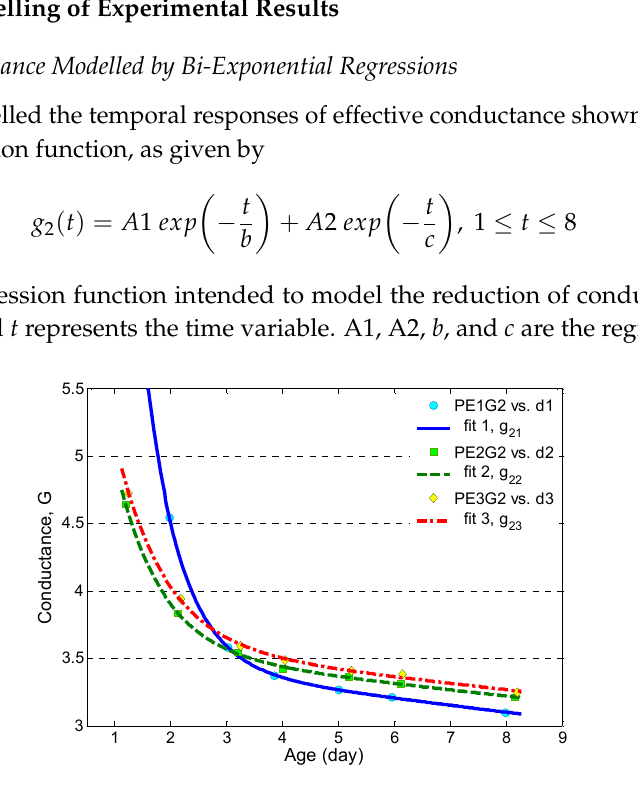
Figure 7. Non ‐ linear regressions of electrical conductance at 2 GHz using bi ‐ exponential functions. Figure 7. Non-linear regressions of electrical conductance at 2 GHz using bi-exponential functions.